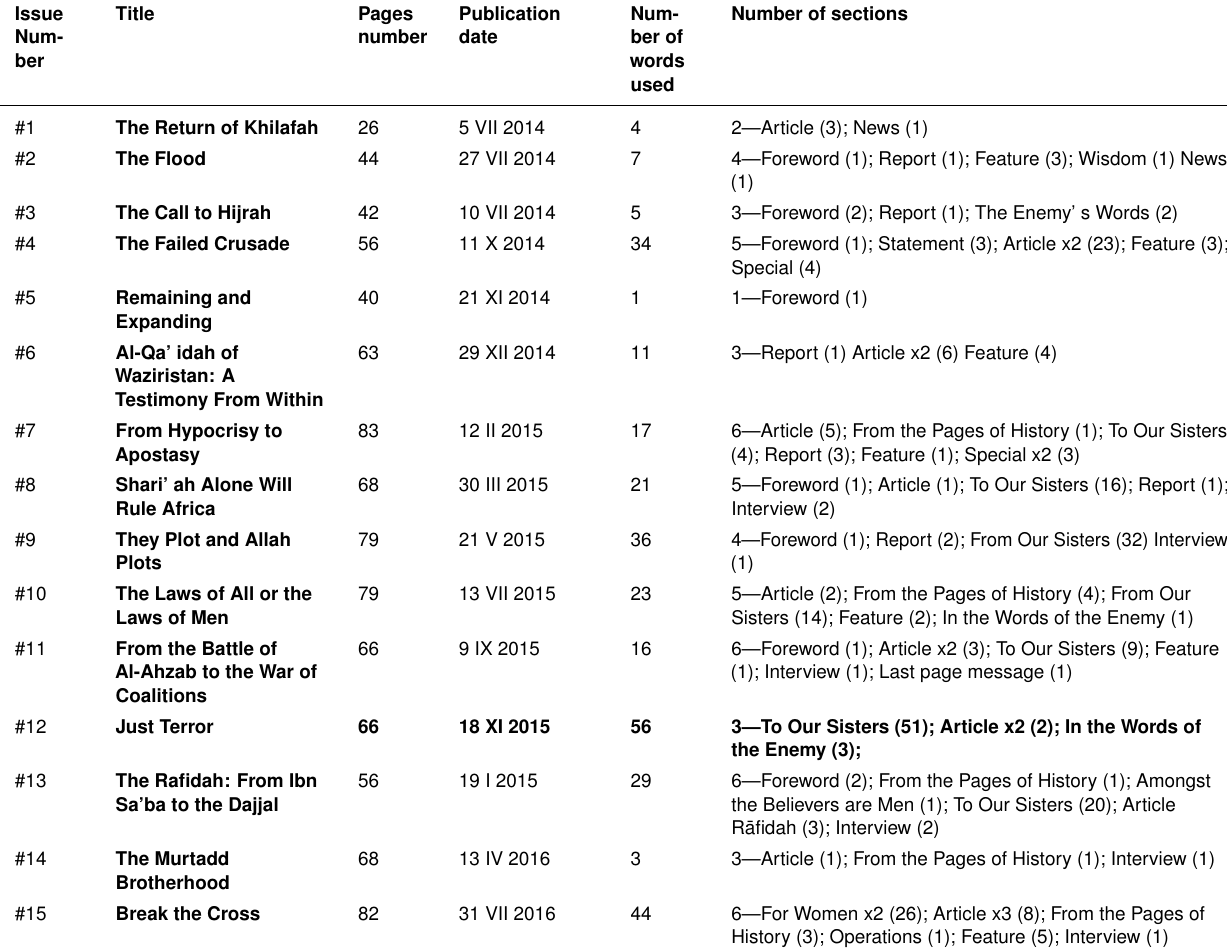
Table 1. The number of words related to women and girls used in the Dabiq